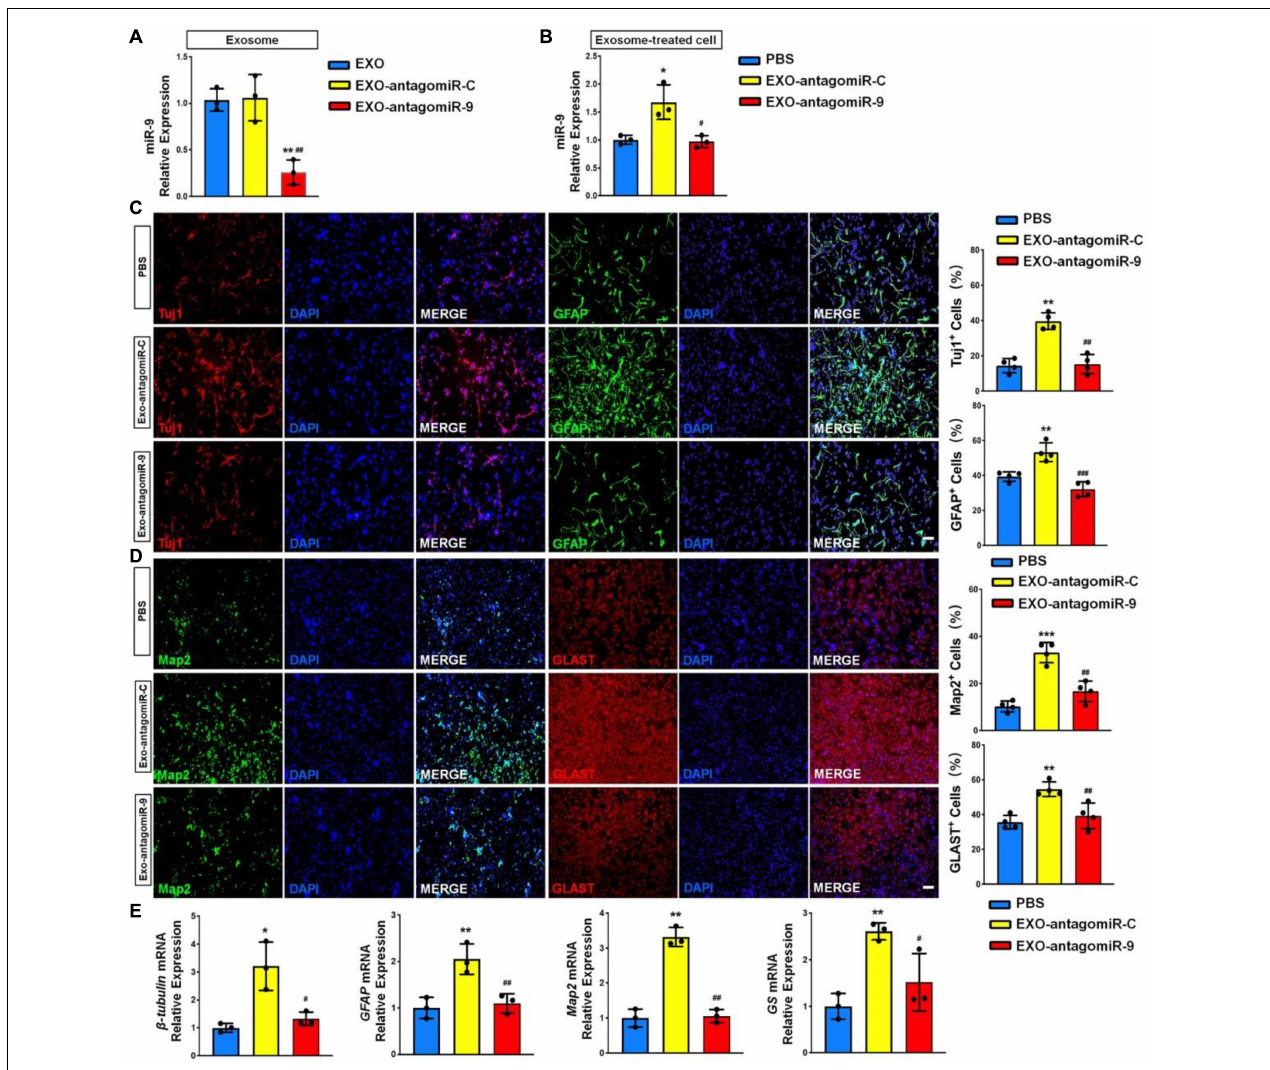
FIGURE 6 | miR-9 mediates the effects of EXOs on NSC differentiation. (A) NSCs were transfected with either antogomiR-C or antogomiR-9. The knockdown of miR-9 expression levels in exosomes derived from antogomiR-9-transfected NSCs were validated by RT-qPCR. (B) NSCs treated with PBS, EXO-antagomiR-9, or EXO-antagomiR-C were cultured for 6 days in differentiation conditions. The expression levels of miR-9 in NSCs treated with PBS or exosomes were determined by RT-qPCR analysis. (C) Representative images of pre-mature cell markers (Tuj1 and GFAP) staining were shown. Proportions of cells exhibiting immunoreactivities of pre-mature cell markers (Tuj1 + and GFAP + ) were determined (in the right panel). (D) Representative images of matured cell markers (Map2 and Glast) staining were shown. Proportions of cells exhibiting immunoreactivities of pre-mature cell markers (Map2 + and Glast + ) were determined (in the right panel). (E) The expression levels of transcripts corresponding to pre-mature cell markers ( β III-tubulin and GFAP ) and matured cell markers ( Map2 and GS ) were determined by RT-qPCR analysis. Data were represented as mean ± SE from three independent experiments. * and ** denote p < 0.05 and p < 0.01 in comparison to control, respectively. # and ## denote p < 0.05 and p < 0.01 in comparison to EXO-antagomiR-C group, respectively. Scale bar 100 µ m in panel (C,D) . *** p < 0.001, ### p <